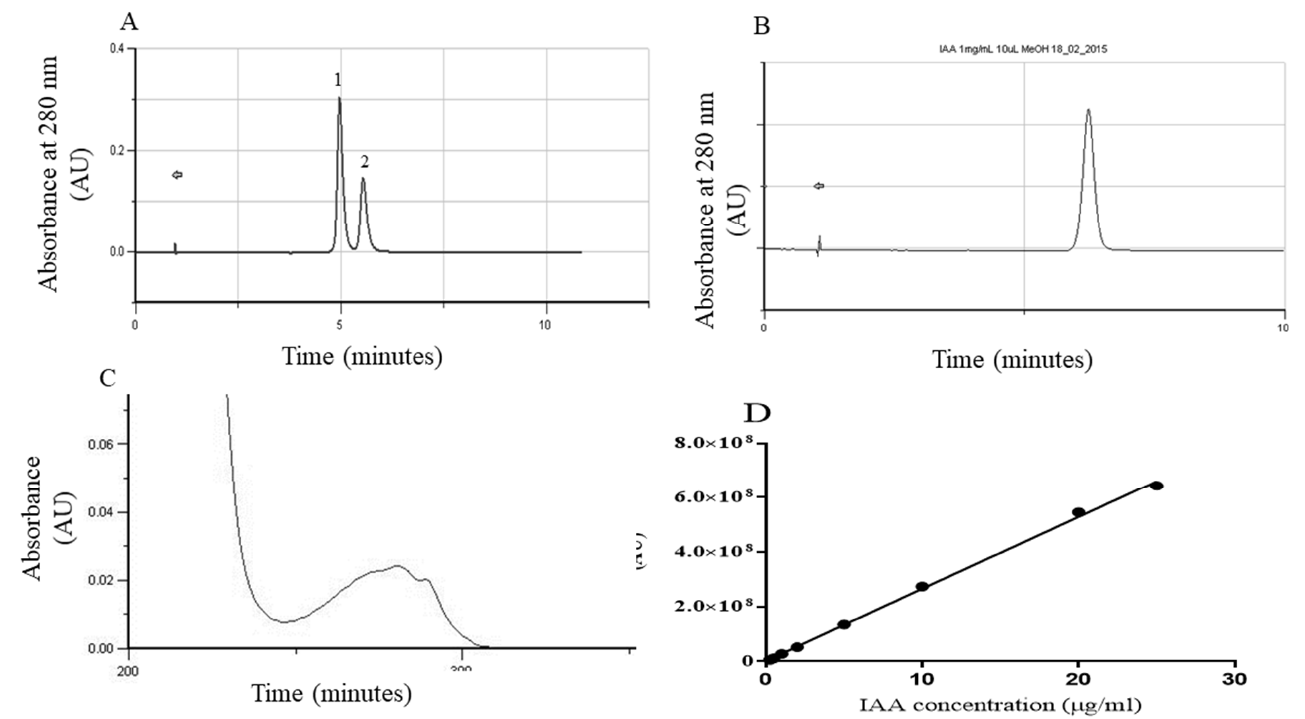
Figure 4. HPLC quantification parameters. ( A ) Retention time of IPA (peak 1, Rt = 5.34 min) and IAA (peak 2, Rt = 6.00 min) in a sample. ( B ) IAA standard (Rt = 5.98 min). ( C ) UV-spectrum of IAA. ( D ) Calibration curve used in the quantification of IAA with the linear equation Area = 2.633 × 10 7 [IAA] + 2.094 × 10 6 (R 2 = 0.9984).